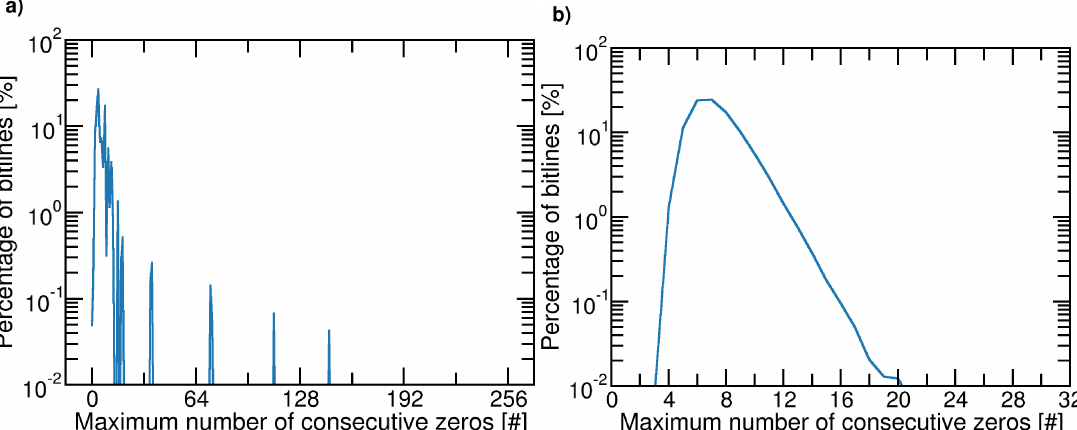
Figure 4. Percentage of bitlines as a function of the maximum number of consecutive zeros in a bitlines. Analysis has been performed considering a 32-bit ALFSR on a memory array of N P = 256 pages and N B = 2 17 cells. Case ( a ): Seeds derived from a mathematical manipulation of the page address; case ( b ): seeds generated randomly.